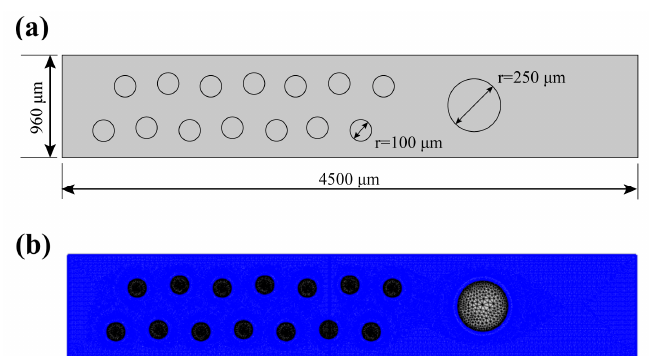
Figure 3. ( a ) Geometric model. ( b ) Mesh distribution near and at boundaries. Table 2. Mesh quality statistics. Minimum Element Average Quality